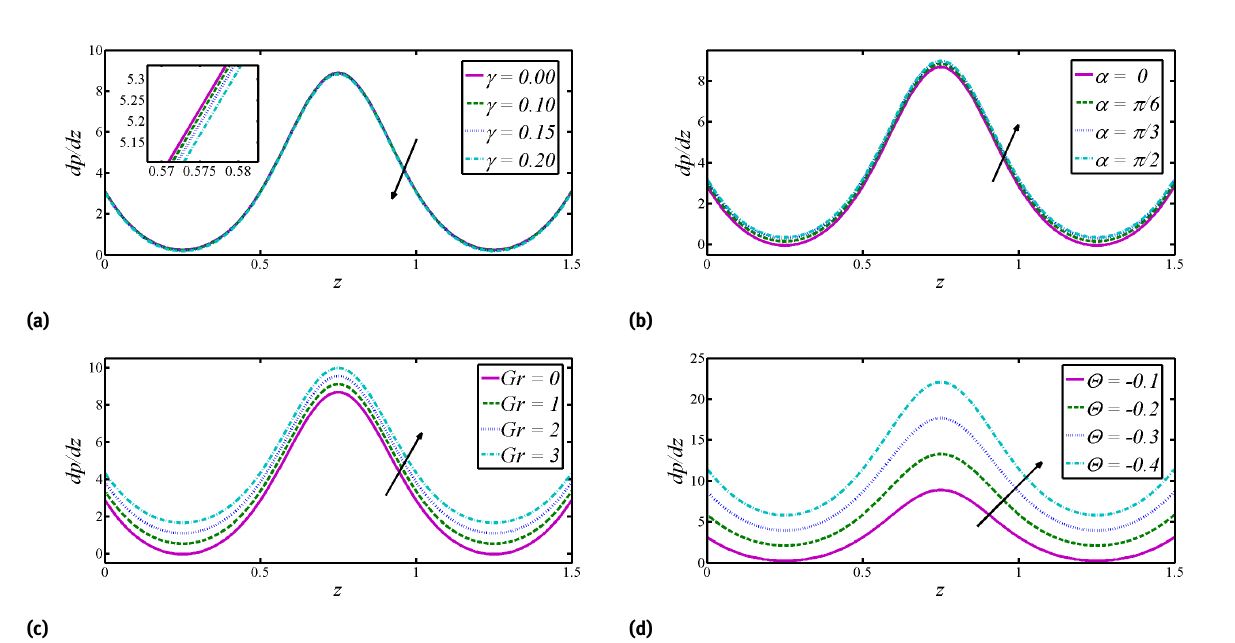
Fig. 4: The pressure gradient verses z for various fluid parameters.